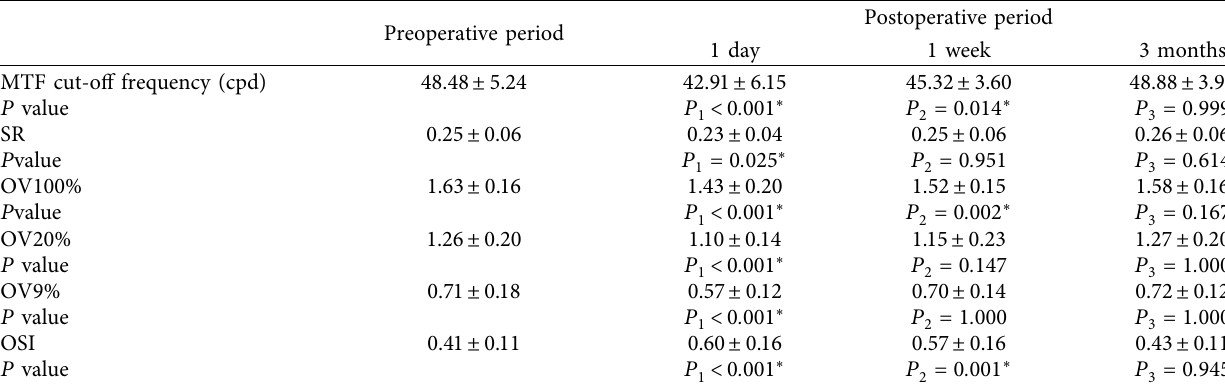
Table 3: Time courses of the optical quality parameters after pure ICL implantation.